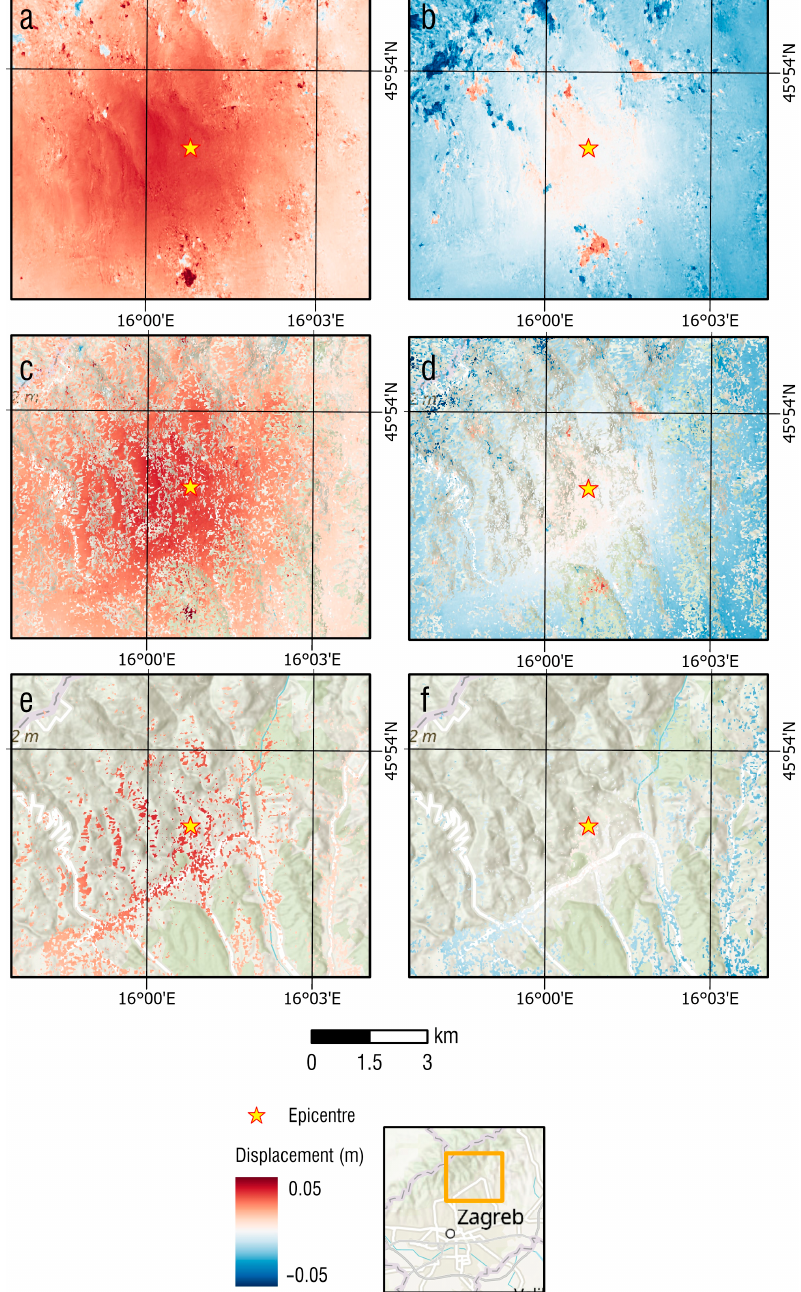
Figure 9. Line-of-sight displacements on the interferometric pairs of Sentinel-1A images (first column: ( a , c , e )) taken on 17 March and 29 March and Sentinel-1B images (second column: ( b , d , f )) taken on 11 and 23 March 2020. First row ( a , b ) represents displacements without regard of the coherence between them ( γ > 0.0); second row ( c , d ) represents displacements masked to appear for medium coherences γ > 0.3; third row ( e , f ) represents displacements masked to appear for strong coherences γ > 0.6.